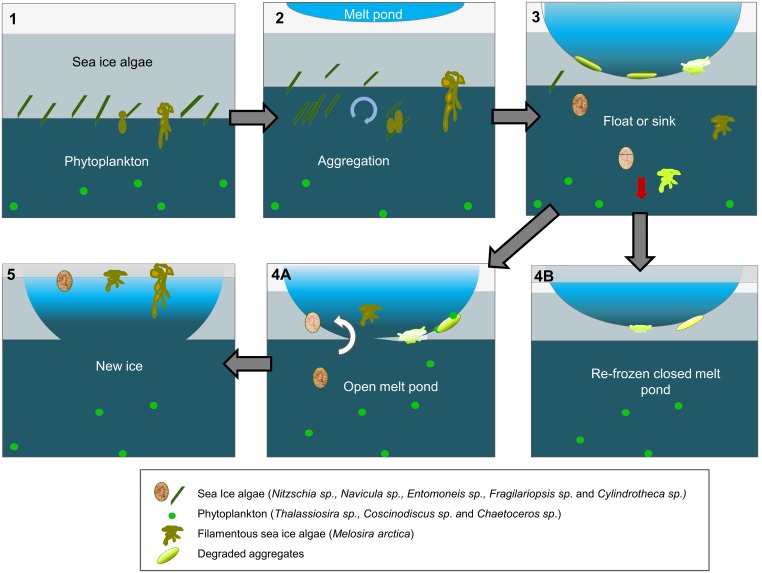
Conceptual model of the mechanisms responsible for the formation and fate of the different types of algal aggregates.(1) In early spring sea-ice algal growth starts before that of phytoplankton. (2) In summer as the sea ice melts and nutrients become limiting, some sea-ice algae are released to the water column or grow into the water column. Due to their stickiness and the under-ice turbulence they form aggregates. (3) In late summer melt ponds grow in depth and the sea-ice algae that are still in the ice are gradually exposed to very low salinities, high irradiances, and nutrient depletion making them accumulate and degrade in the pond. Depending on the environmental conditions, some sub-ice aggregates sink and others remain floating. (4) In early autumn, the melt ponds can either open completely allowing some phytoplankton species to come into the melt pond, or they can refreeze again, becoming second year ice. (5) In autumn those melt ponds that were open to the seawater freeze again, trapping the floating aggregates that were not grazed in the newly formed ice.